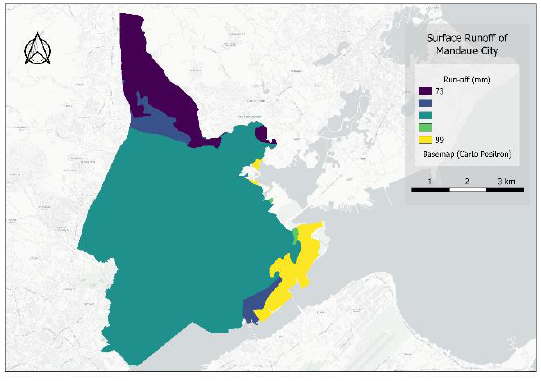
Figure 4. Surface Runoff map of Mandaue City,